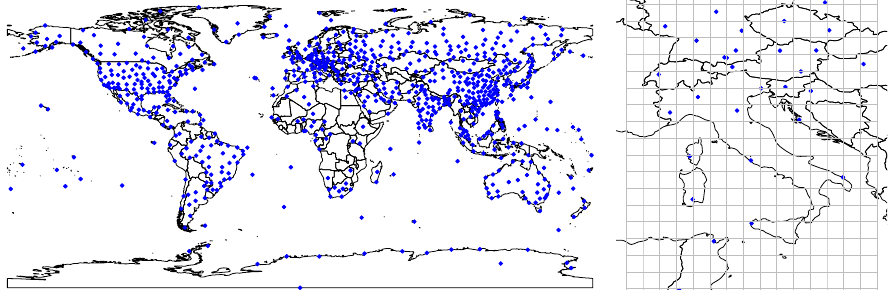
Figure 1. ( Left ) Locations of 813 weather balloon stations. ( Right ) A comparison of weather balloon stations collaborating with NCEP in Europe and GFS data grid (crossings of the gray grid with one-degree resolution). Data are from www.ncdc.noaa.gov (accessed on 13 November